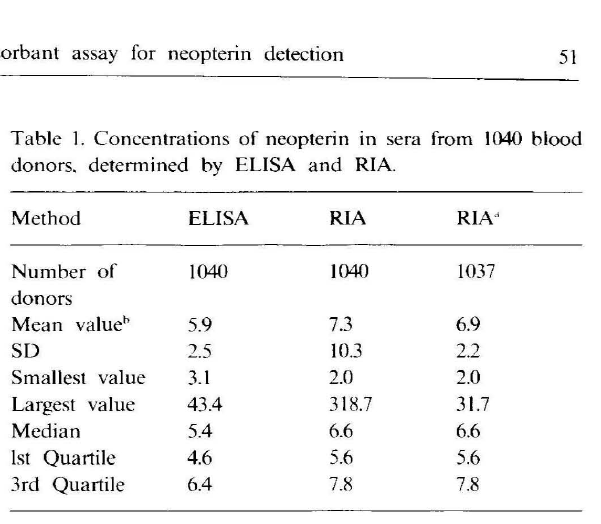
The frequencies of neopterin concentrations above 10.0 nmol/L obtained were 42/ 1040 (4.0%) for ELISA and 63/ 1040 (6.1%) for RIA. There was ag reement between both methods in 999 (96.0%) cases (967 below 10.0 nmol/L.; 32 above); 31 were elevated